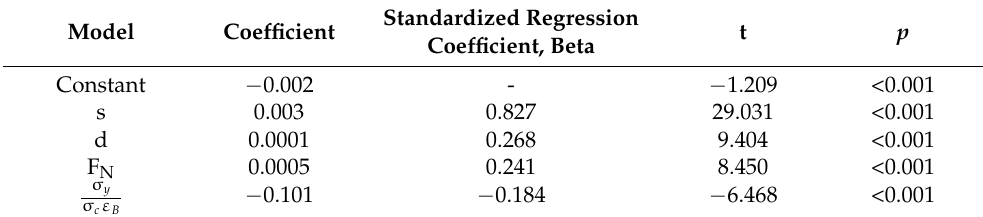
Table 10. Coefficients of the regression model for multi-asperity